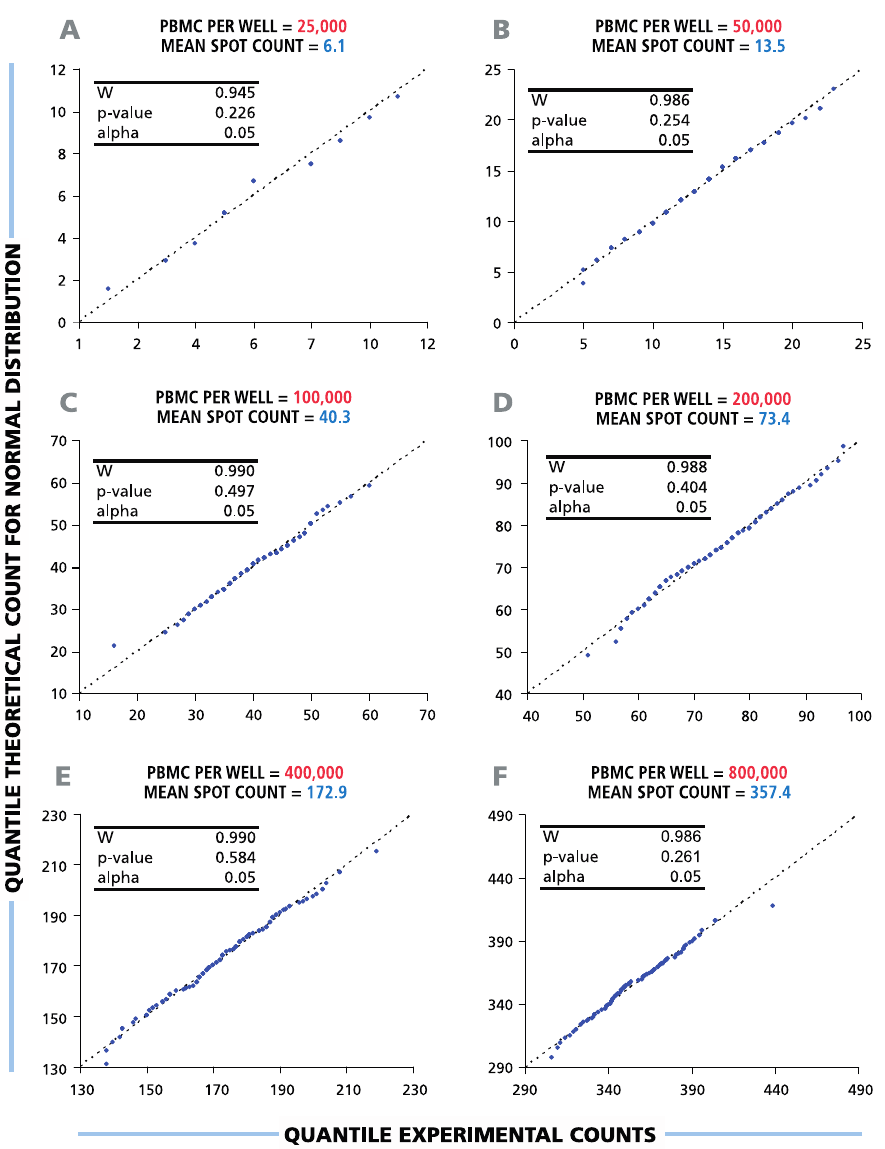
Figure 2. Spot counts between six and 350 per well follow a normal distribution function. Therefore, parametric statistical tests ( t- test, ANOVA) can be used to discriminate between negative and positive responses over the full range of potential ELISPOT assay results. A representative experiment with a single HLA-A2-positive donor’s CD8+ T-cell IFN- γ response to EBV peptide LMP2A (426 – 434) is shown. For each cell number plated per well ( A – F ), the distributional properties of the spot counts were analyzed in 120 replicate wells using diagnostic plots (Q-Q plots) and Shapiro-Wilk statistical normality tests with a significance level of α = 0.05 (shown in the picture inserts). The X-axis labels the quantile experimental counts; the Y-axis labels the quantile theoretical counts for the normal distribution. “W” is the calculated Shapiro-Wilk